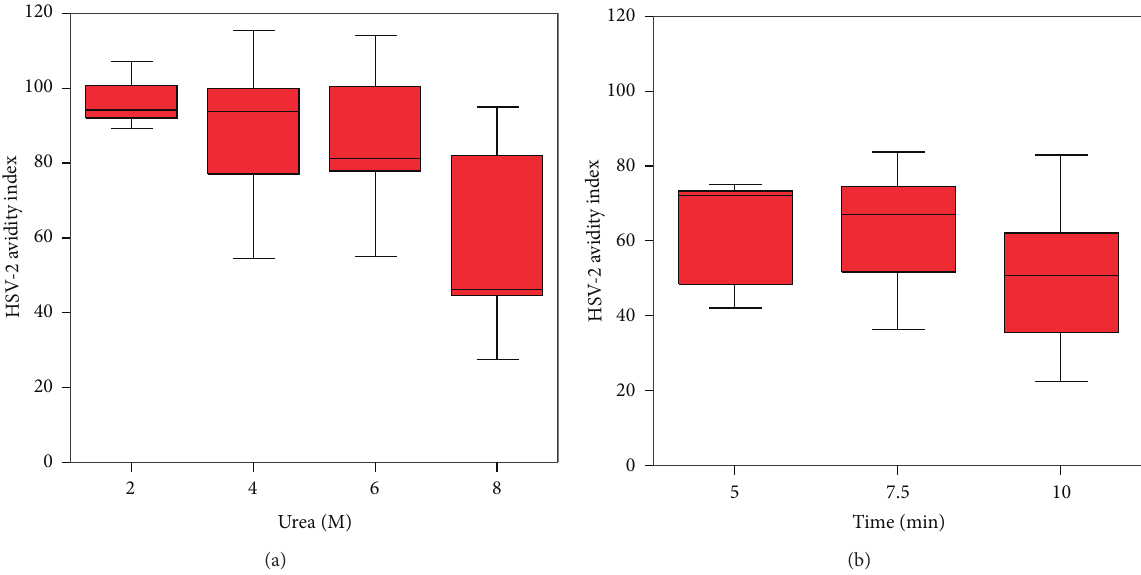
Figure 1: Standardization of avidity test to IgG antibodies against HSV-2. Molar urea concentration (a), time in minutes (b). Box plot. Median, 25, and 75 quartile, limits to